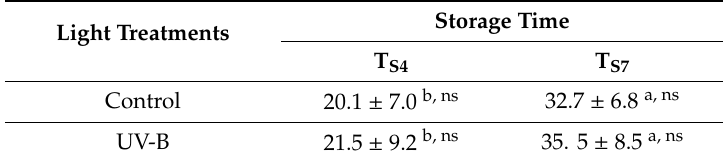
Table 3. Percentage loss in fresh weight (% FWLR) during the storage time (at T S4 and T S7 ) of O. basilicum leaves from control and supplemental UV-B light treatments.